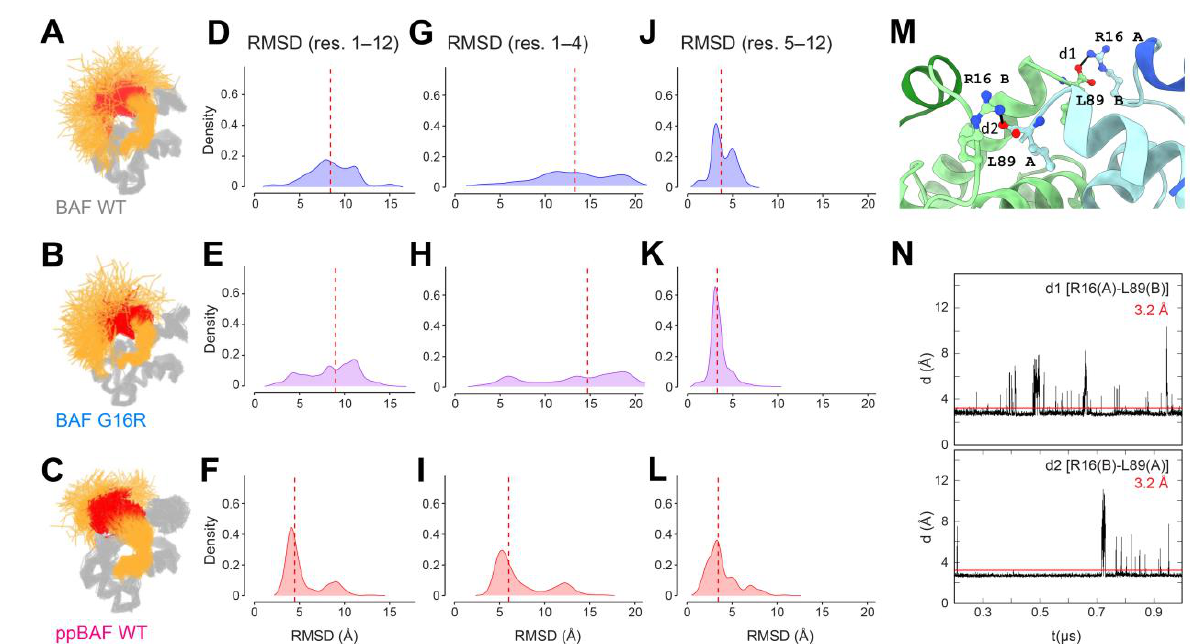
Figure 4. The structure of helix α1 in BAF Gly16Arg is less variable than in BAF WT. ( A – C ) Superimposition of a set of 6000 monomeric structures extracted from the MD trajectories of BAF WT (BAF; [32]), BAF Gly16Arg and di-phosphorylated BAF WT (ppBAF; [32]). Residues 20 – 89 are colored in grey and residues 1 to 19 are colored in orange except for residues 5 to 12 (transiently forming helix α1) that are colored in red. The structures were superimposed on the core region of the reference BAF crystal structure 1CI4 (helix α 3, α 4, α 5 and α 6) by minimizing the RMS deviation of the Cα coordinates of the extracted structures with respect to the ones of the reference structure. ( D – F ). Dispersion of the structures of the N-terminal region (residues 1 to 12) is represented by p lotting the distribution histograms (in density mode) of the RMS deviations (RMSD) of the Cα of residues 1 to 12 with respect to the reference structure 1CI4. ( G – I ) Dispersion of the structures of the N-terminus (residues 1 to 4) is represented by plotting the same distribution histograms calculated on residues 1 to 4. ( J – L ) Dispersion of the structures of residues forming helix α1 (residues 5 to 12) is represented by plotting the same distribution histograms calculated on residues 5 to 12. The vertical red dotted lines show the median value of these distributions. ( M ) A representative frame extracted from the MD simulation of BAF Gly16Arg is displayed, with each BAF monomer being colored in light blue and green, respectively (N-terminal regions from residues 1 to 12 in dark blue and green, respectively). The Arg16 and Leu89 residues are displayed in ball-and-stick. The position of the MD simulation-identified salt-bridge is visualized by a black line between the guanidinium group of Arg16 of one monomer and the C-terminal carboxyl group of Leu89 of the other monomer. ( N ) Plots of the distance between the guanidinium group of Arg16 of one monomer (A, B) and the C-terminal carboxyl group of Leu89 of the other monomer (B, A) along one of the 1 µs MD trajectories. This distance is mostly constant along the three 1 µs MD trajectories calculated for BAF Gly16Arg.